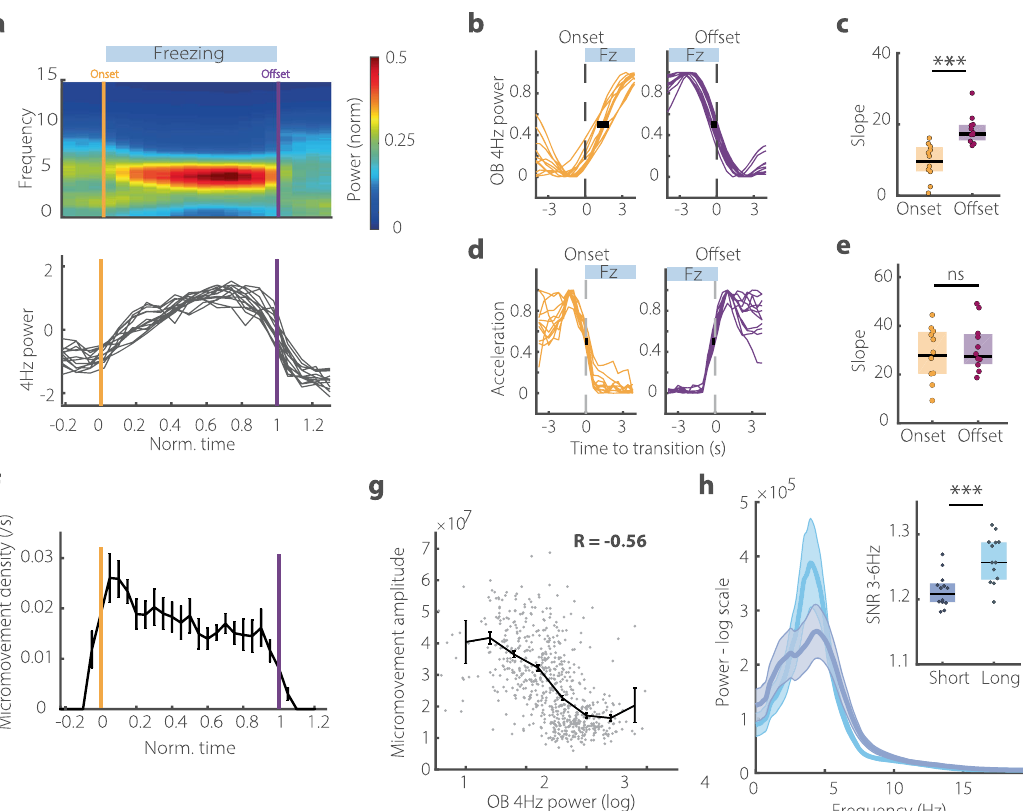
Fig. 4 Stronger 4 Hz power is linked to more sustained and stable freezing episodes. a OB spectrogram (top) and mean power in the 4 Hz band (bottom) triggered on freezing periods of normalized duration for all mice. Note the asymmetric rise and fall of 4 Hz power during the freezing bout with a gradual onset and steep offset. ( n = 15 mice). b , d OB 4 Hz power ( b ) and head acceleration ( d ) triggered on onset (left, orange) and offset (right, purple) of freezing bouts. Both measures are normalized between 0 and 1. Black bar indicates the standard deviation at the midpoint. ( n = 11, 11 mice, only mice with suf fi cient number of 4 s bouts of freezing are retained). c , e Slope of onset and offset curves of and OB 4 Hz power ( c ) head acceleration ( e ) to quantify the difference in transition speed, estimated using a sigmoid fi t. (Wilcoxon rank-sum: zval = − 3.61, − 0.32; p = 3e − 3, 0.74, n = 11). f Density of micromovements during freezing periods of normalized duration showing that they decrease throughout the episode, following a similar dynamic to 4 Hz increase. These small head movements are detectable using head accelerometer only but are not readily visible on video measurements and often coincide with the bips of the CS. ( n = 11 mice). Error bars are SEM. g The amplitude of the micromovements elicited by CS pips is correlated with the instantaneous 4 Hz power. (Pearson correlation: R = − 0.56, p = 2.3e − 54, n = 578 movements from 11 mice). Error bars are SEM. h Averaged OB spectra during short (<10 s) and long (>10 s) freezing periods showing stronger 4 Hz during long episodes. Error bars are SEM. Inset: average signal-to-noise ratio of 3 – 6 Hz band during short and long episodes. (Paired Wilcoxon signed-rank test: Signed Rank statistic = 0, p = 2.44e − 4, n = 13). In all panels, boxplots show median and interquartile